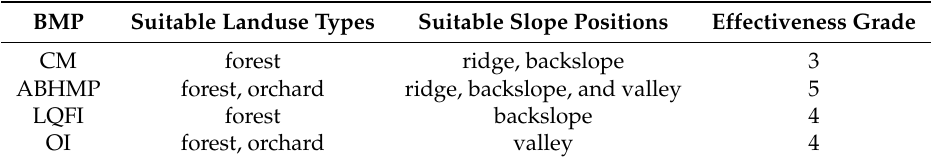
Table 3. Suitable landuse types/slope positions and the overall environmental effectiveness grade of the four BMPs (CM = Closing measures, ABHMP = Arbor–bush–herb mixed plantation, LQFI = Low-quality forest improvement, OI = Orchard improvement) (adapted from